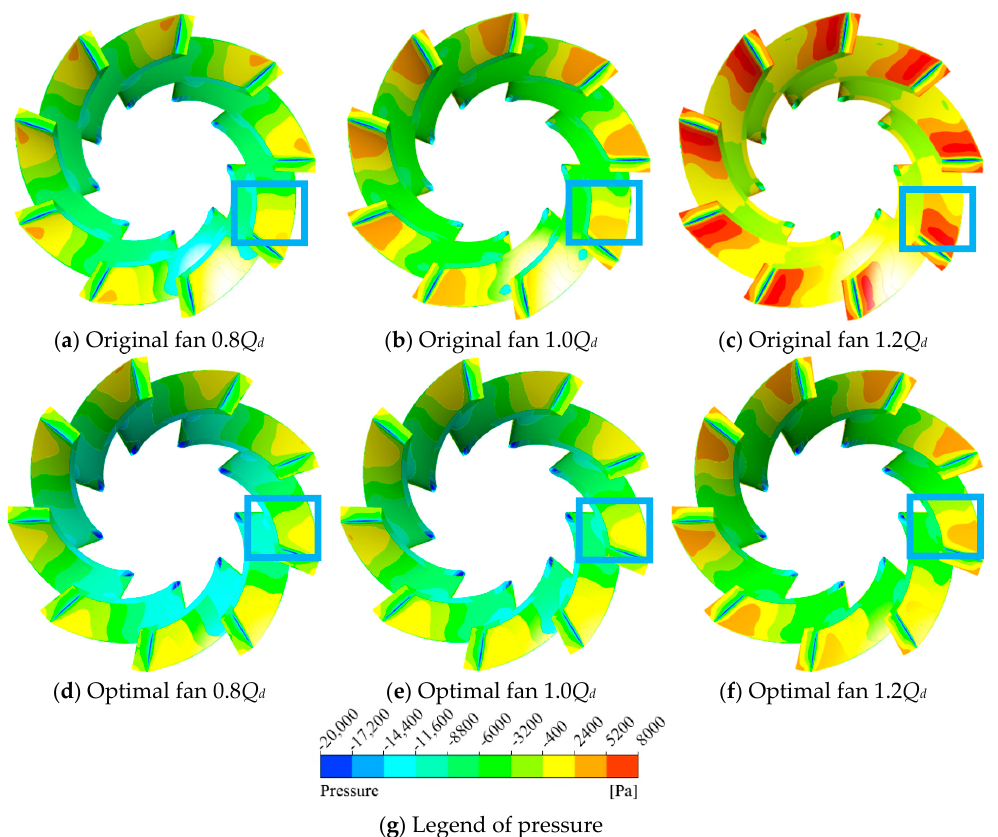
Figure 5. Pressure distribution of pressure side in impeller. ( a ) Original fan 0.8 Q d ; ( b ) Original fan 1.0 Q d ; ( c ) Original fan 1.2 Q d ; ( d ) Optimal fan 0.8 Q d ; ( e ) Optimal fan 1.0 Q d ; ( f ) Optimal fan 1.2 Q d ; ( g ) Legend of